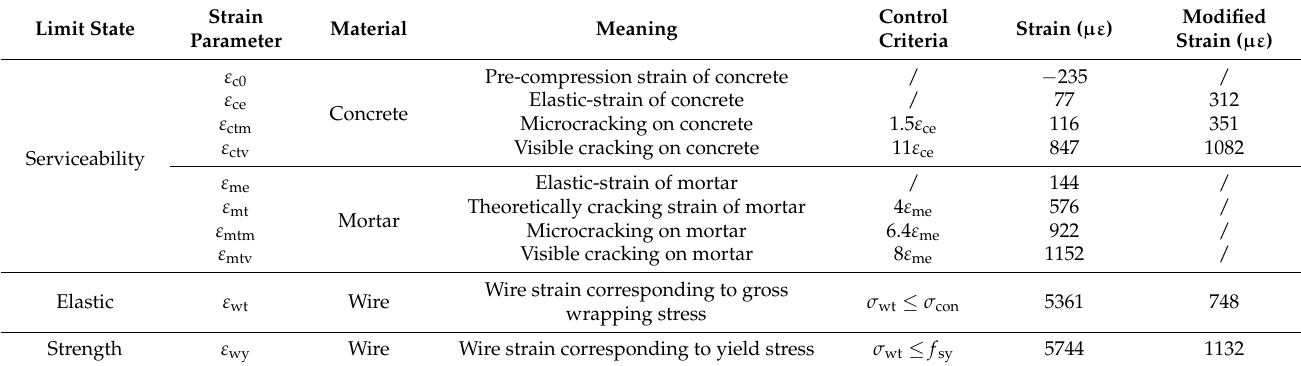
Table 3. Calculation and modification results of the control strain.